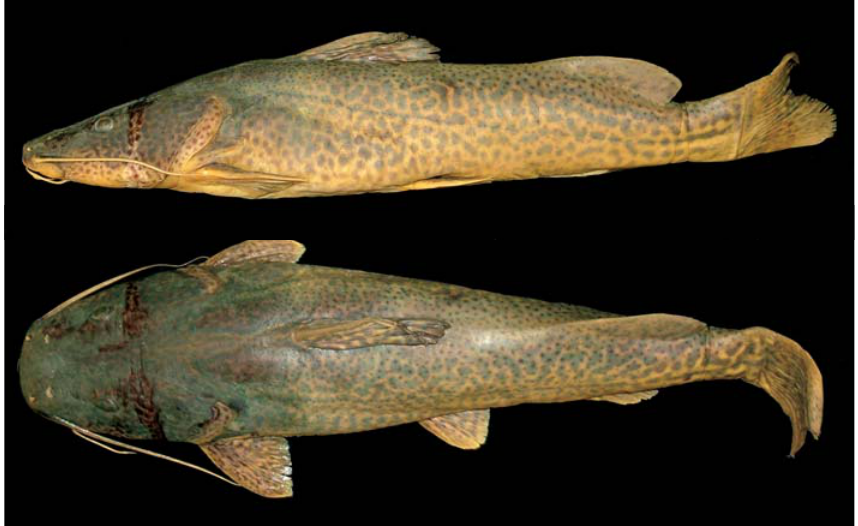
Fig 2. Lateral and dorsal views of S. parahybae. MNRJ 12237, 384 mm SL, rio Paraíba do Sul, at confluence with rio Piabanha and rio Paraibuna, Pontal, Rio de Janeiro,